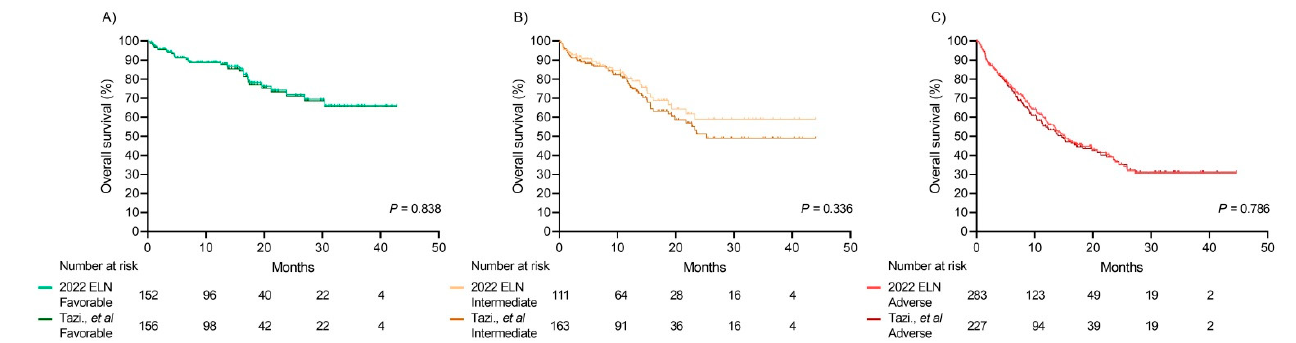
Figure 9. Overall survival curves according to 2022 ELN risk classification and Tazi et al. [2] genomic AML classification: ( A ) Favorable, ( B ) Intermediate and ( C ) Adverse risk groups..